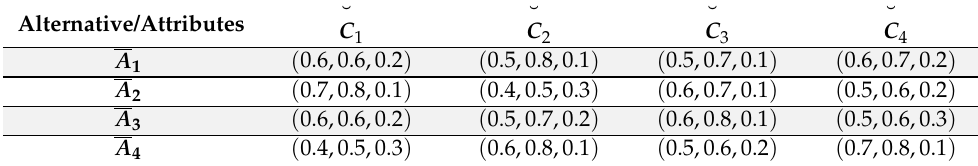
Table 3. T-spherical fuzzy decision matrix A 3 .